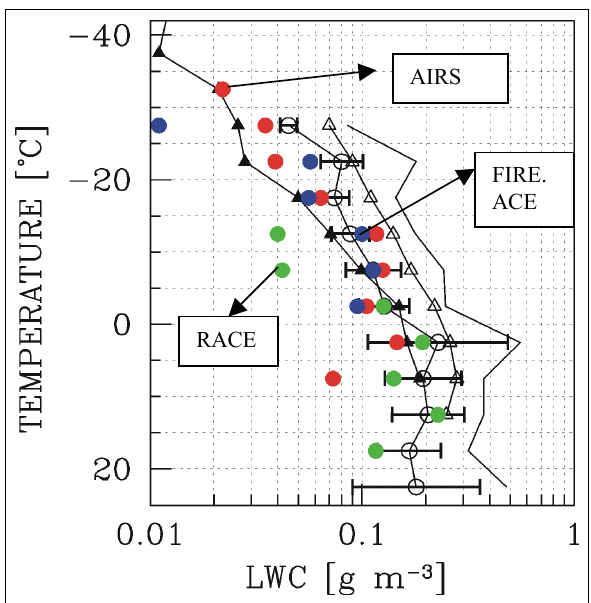
Fig. 2. Profiles of LWC versus T at 5 ◦ C intervals; solid triangles are from Mazin (1995) for total water content, blank triangles are for Feigelson (1978) for LWC, blank circles are for Gultepe et al. (1997) for LWC. The bars show relative variability in LWC from GI. The solid line at the far right represents mean+sd of LWC from